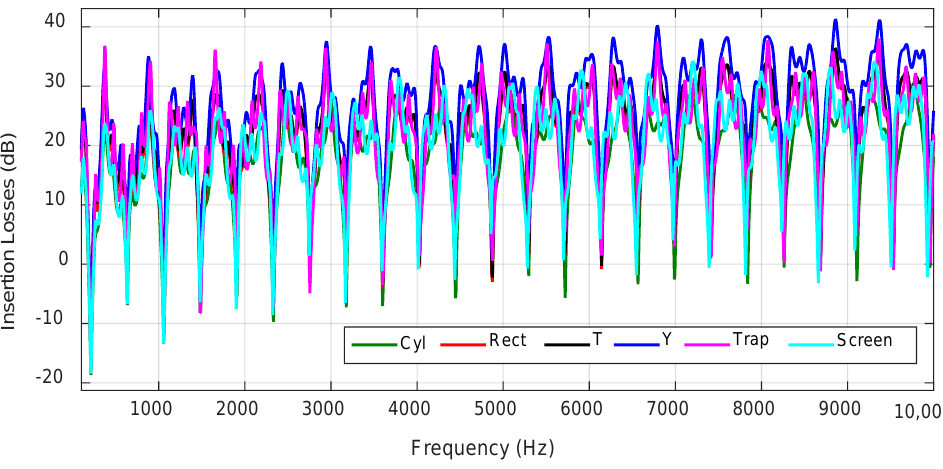
Figure 14. IL in Configuration 3 ‘Ambulance–Person’ for single caps and a single screen barrier as a reference.